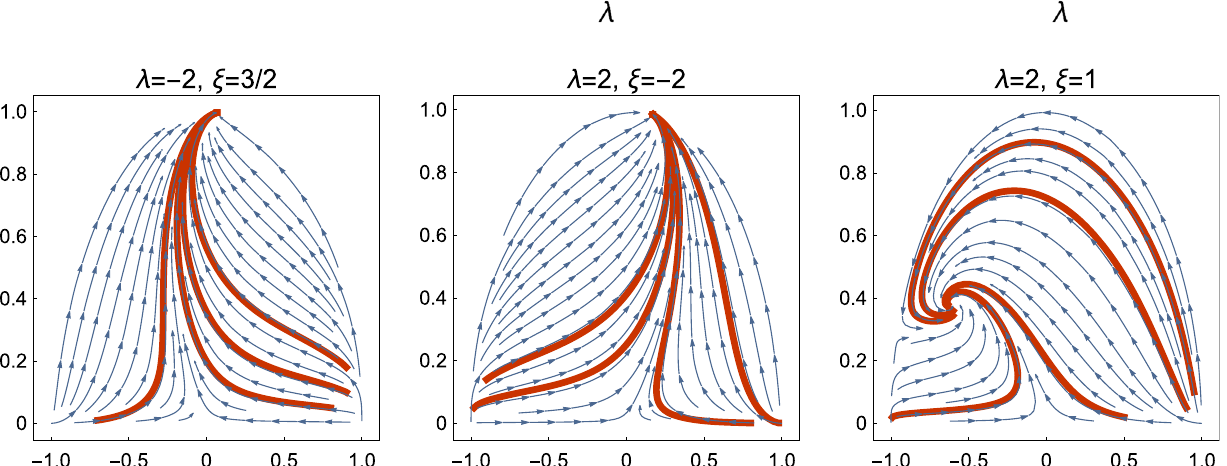
unique attractor; for (λ,ξ) = ( 2 , − 2 ) point ¯ A 3 is the unique attractor, while point ¯ A 4 is an attractor for the plot with (λ,ξ) = ( 2 , 1 ) . Solid (cid:11) (cid:10) − 2 , 3 point A 2 is the lines correspond to real 2